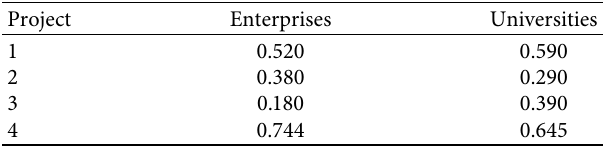
Table 1: Evaluation data of innovation projects by universities and